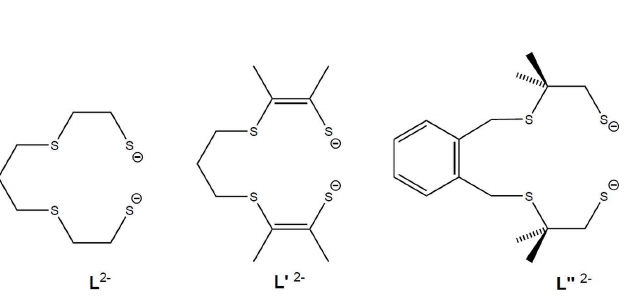
Figure 3 Displacement ellipsoid (30% probability) drawing for [Ni( L 0 )FeCp*(CO)] + , as observed in the structure of [Ni( L 0 )FeCp*(CO)][PF 6 ]. Generated using ORTEP-3 for Windows (Farrugia, 2012).